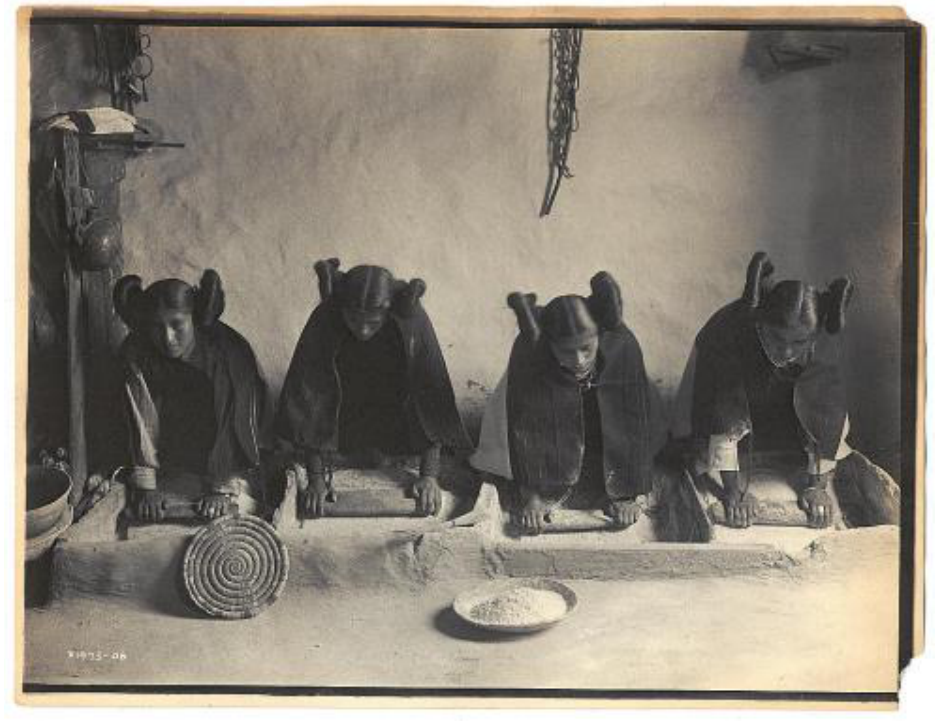
Figure 7 Edward S. Curtis, The mealing trough – Hopi , ca. 1906. Digital file from original. Library of Congress, Prints & Photographs Division, Edward S. Curtis Collection, [LC-DIG-ppmsca-05085]. Recent scholarship on Curtis seeks to move beyond the critique of his posing and staging activities because, as Aaron Glass notes, “it has tended to grant Curtis sole authorship and control, completely ignoring the active participation and possibly strate gic agency of the indigenous people who chose to sit and post and dress up for him.” 34 Glass instead examines the motivations of Kwakwaka ’wakw sitters pictured in Volume Ten of Curtis’s extensive book series The North American Indian . He focuses on George Hunt, a figure of English and Alaskan Tlingit descent who married into the Kwakwaka